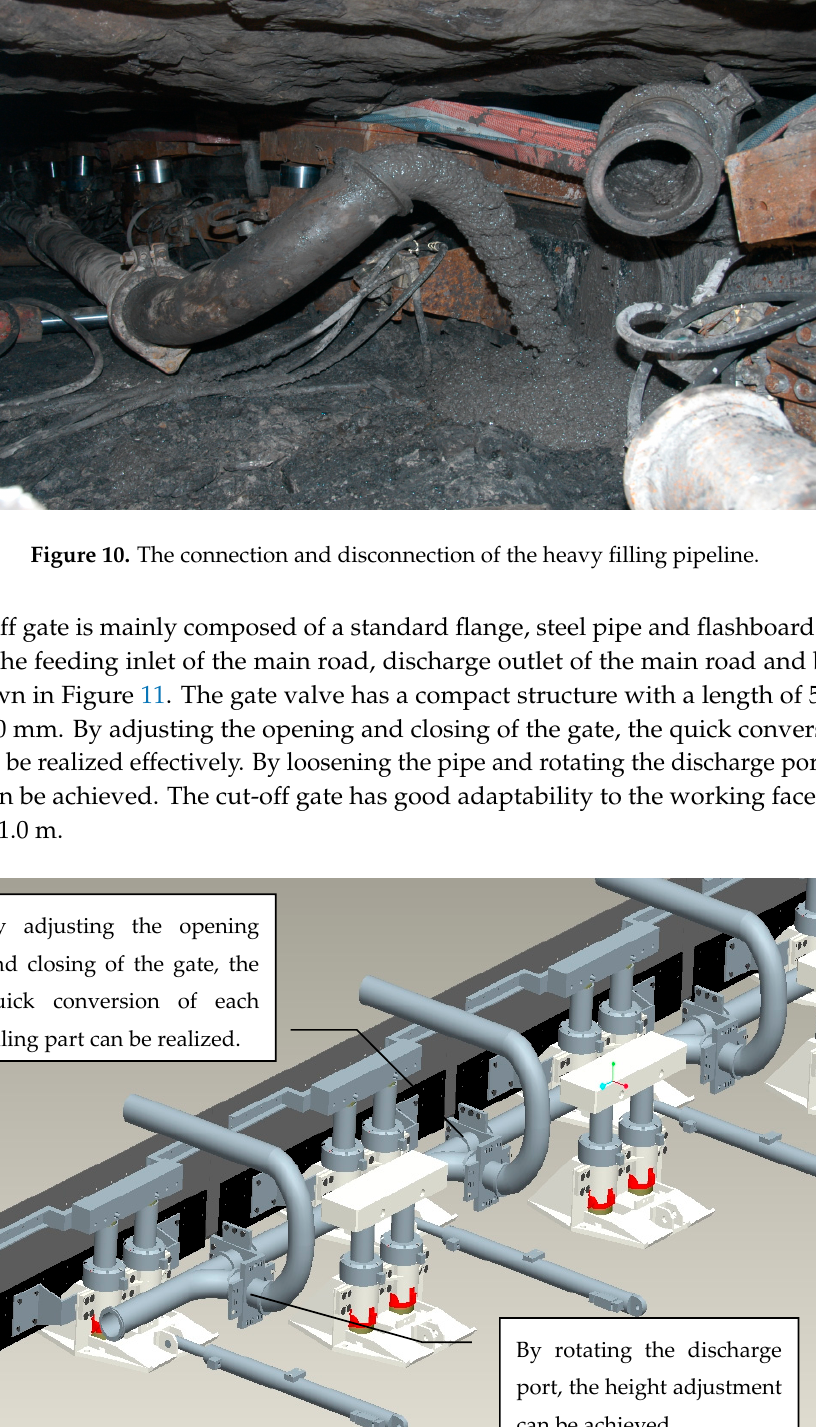
Figure 11. Sketch map of the “Y” type two-way selection cut-off gate.